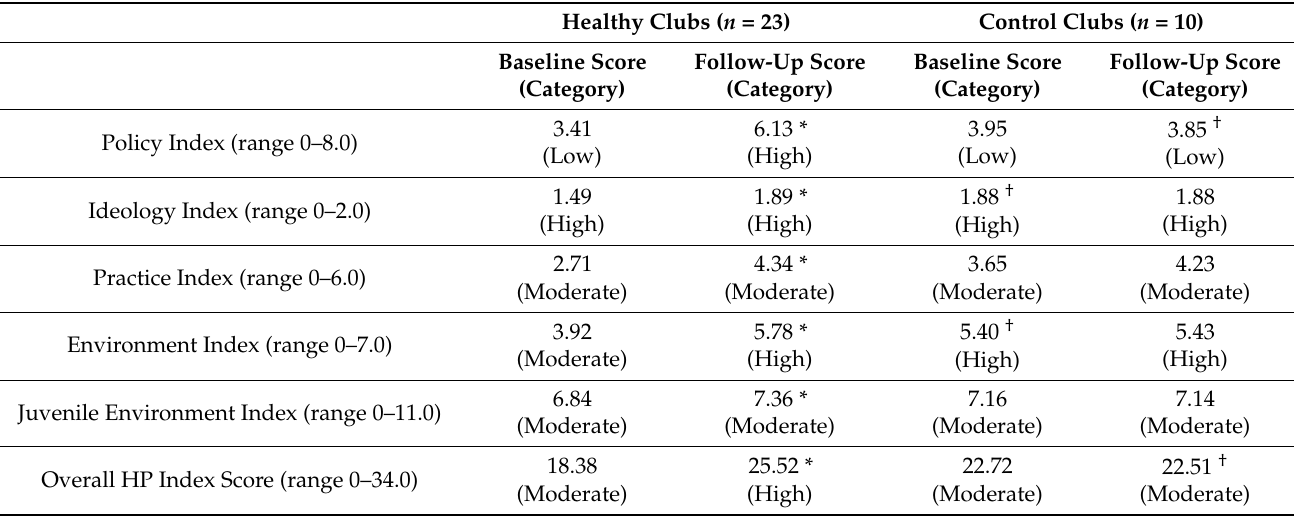
Table 3. Baseline and follow-up health promotion orientation of Healthy and Control Clubs.